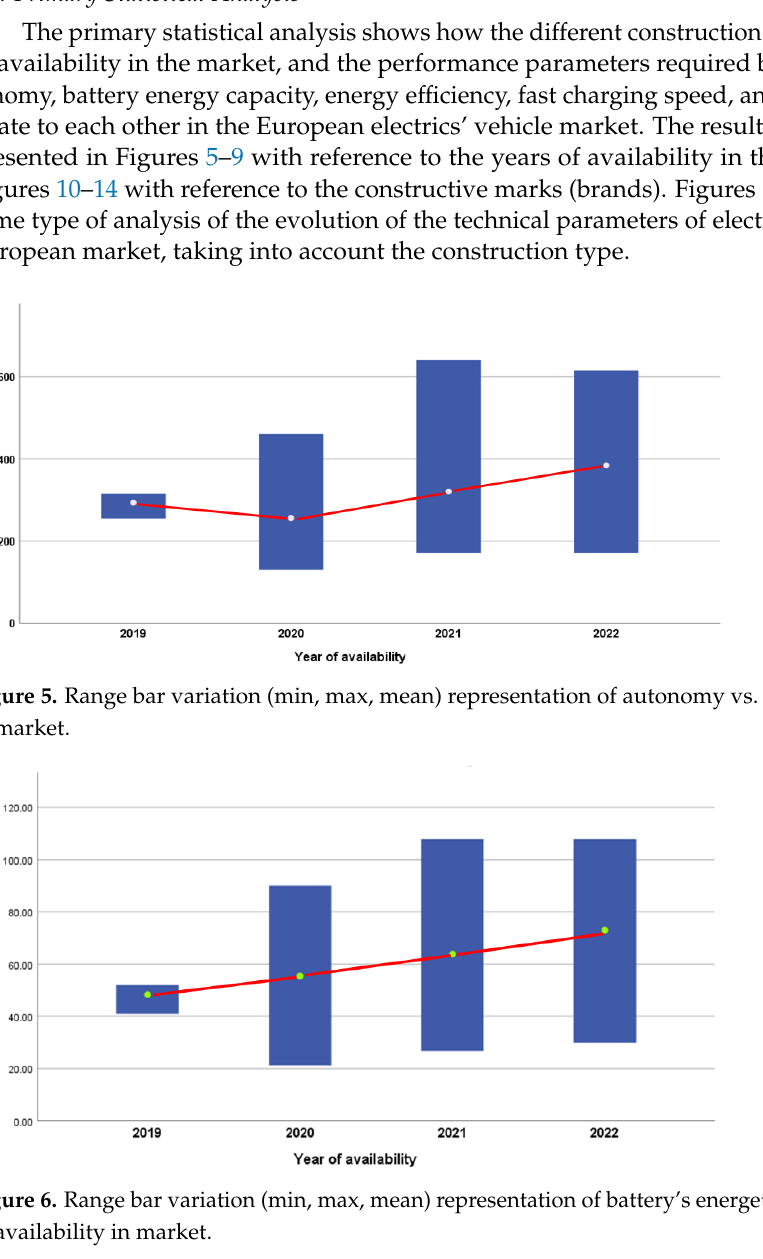
Figure 7. Range bar variation (min, max, mean) representation of energy efficiency vs. year of avail- ability in market.